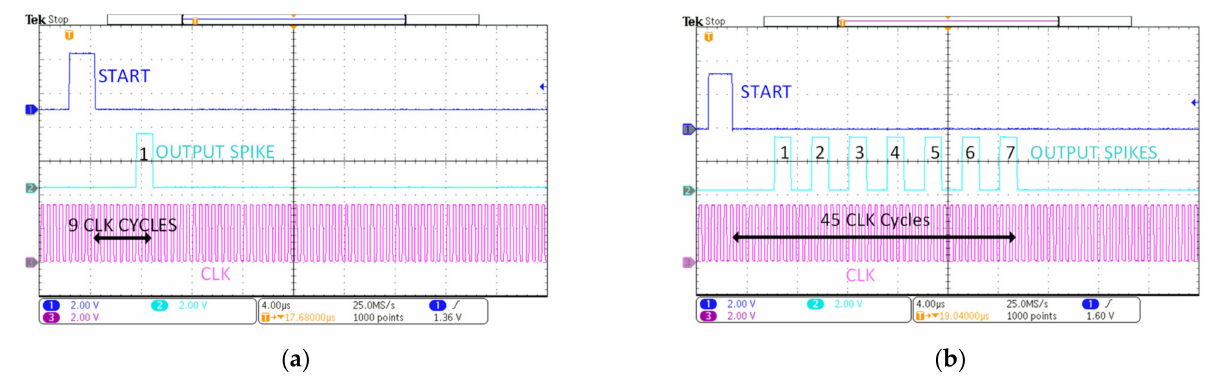
Figure 11. Measurement results for the spike propagation: ( a ) One input spike propagates through all layers; ( b ) seven input spikes propagates through all layers.